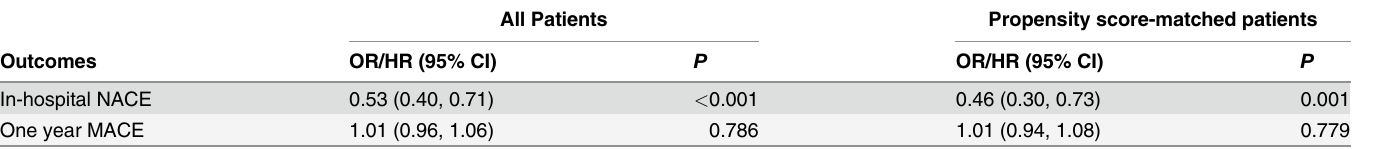
Table 4. The adjusted rates for the major endpoint of TRA vs. TFA.